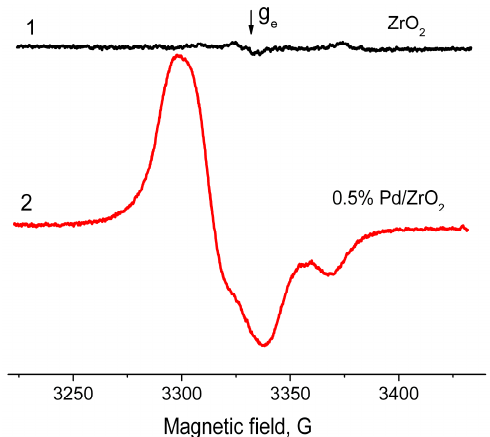
Figure 6. EPR spectra of radical anions emerged after adsorption of TNB from its 2 × 10 − 2 M solution in toluene on surface of ZrO 2 ( 1 ) and 0.5% Pd/ZrO 2 ( 2 ) catalyst. T act = 100 °C.